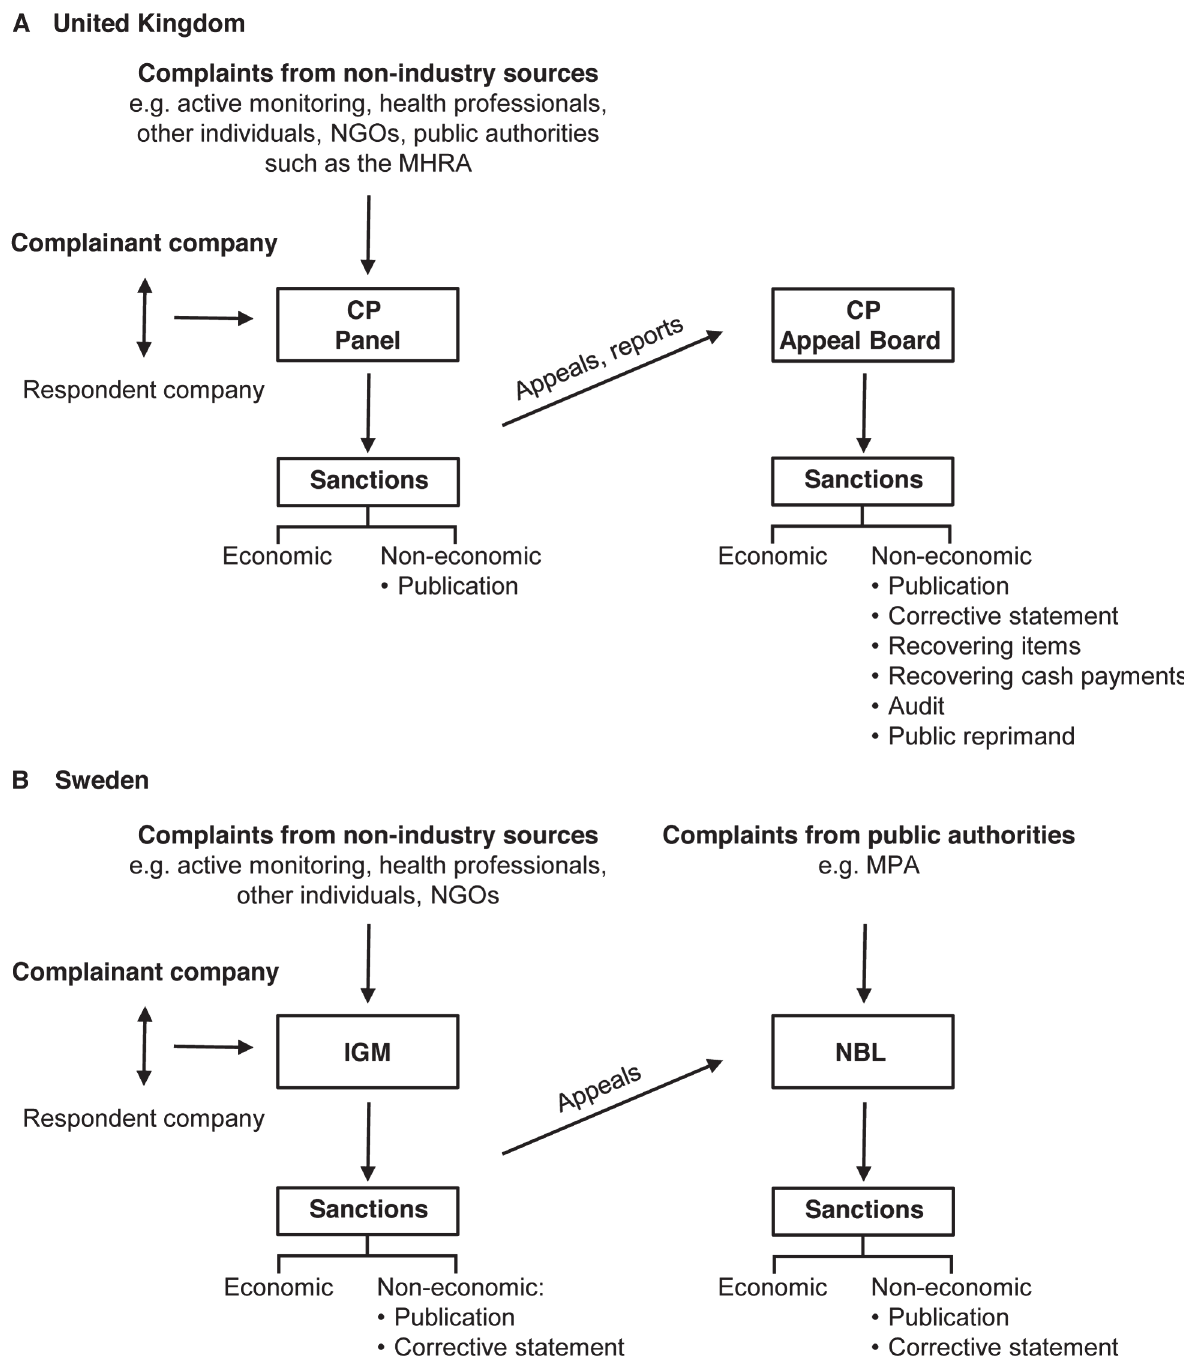
Fig 1. Self-regulatory schemes in the United Kingdom and Sweden. Both countries have a dual-structure self-regulatory system. Complaints emerge from either industry or non-industry sources. In the former case, companies must first attempt to settle disagreements through inter-company dialogue. The Code of Practice (CP) Panel in the UK (A) and the IGM in Sweden (B) impose economic sanctions on violating companies and also publicize rulings. In addition, the IGM may require a company to issue a corrective statement. The CP Appeal Board and the NBL deal with appeals. The CP Panel can also report any company to the CP Appeal Board whose conduct under the Code is of special concern. The CP Appeal Board has a greater range of non- economic disciplinary measures at its disposal than does the NBL. The respective industry trade group may discipline companies in extreme cases (not shown). NGOs, non-governmental